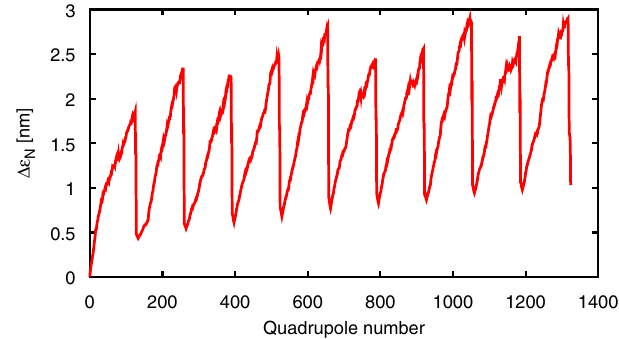
FIG. 2. Emittance growth along the CLIC main linac after beam-based alignment and tuning of 20 knobs each controlling the vertical displacement of an accelerating structure. The char- acteristic zigzag pattern is caused by two knobs canceling wake- fields at each of ten positions along the linac. Between these bump positions emittance growth is not suppressed.